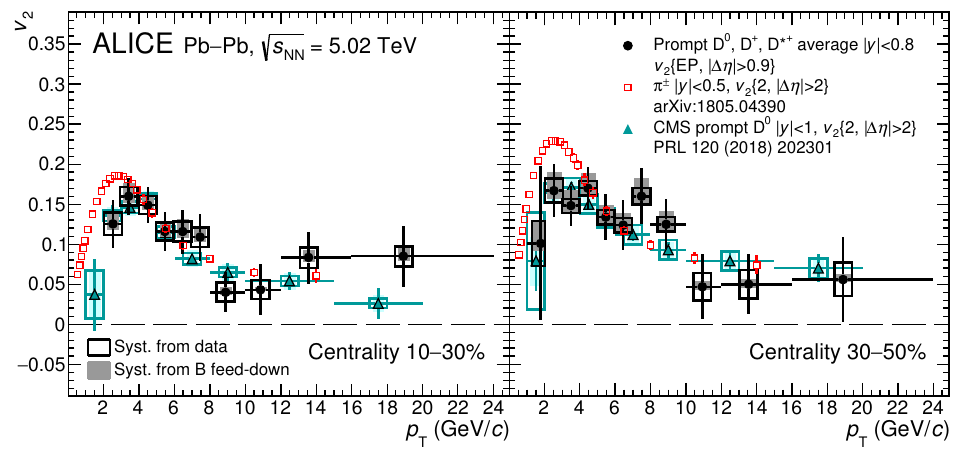
p s = 5 : 02 TeV in NN